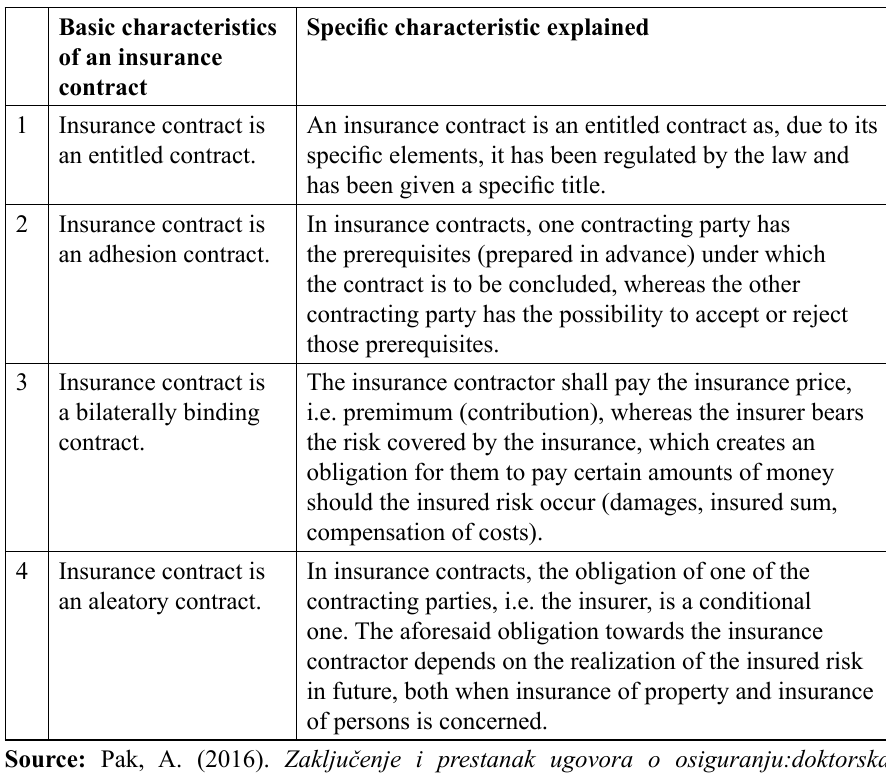
Table 1. Characteristics of an insurance contract Basic